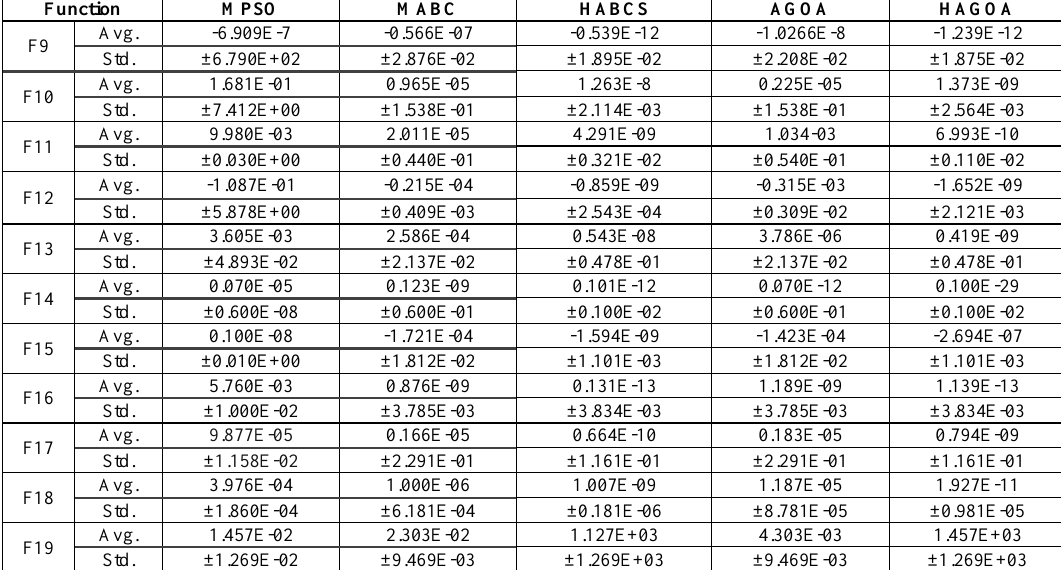
Table 4. Performance evaluation on multimodal